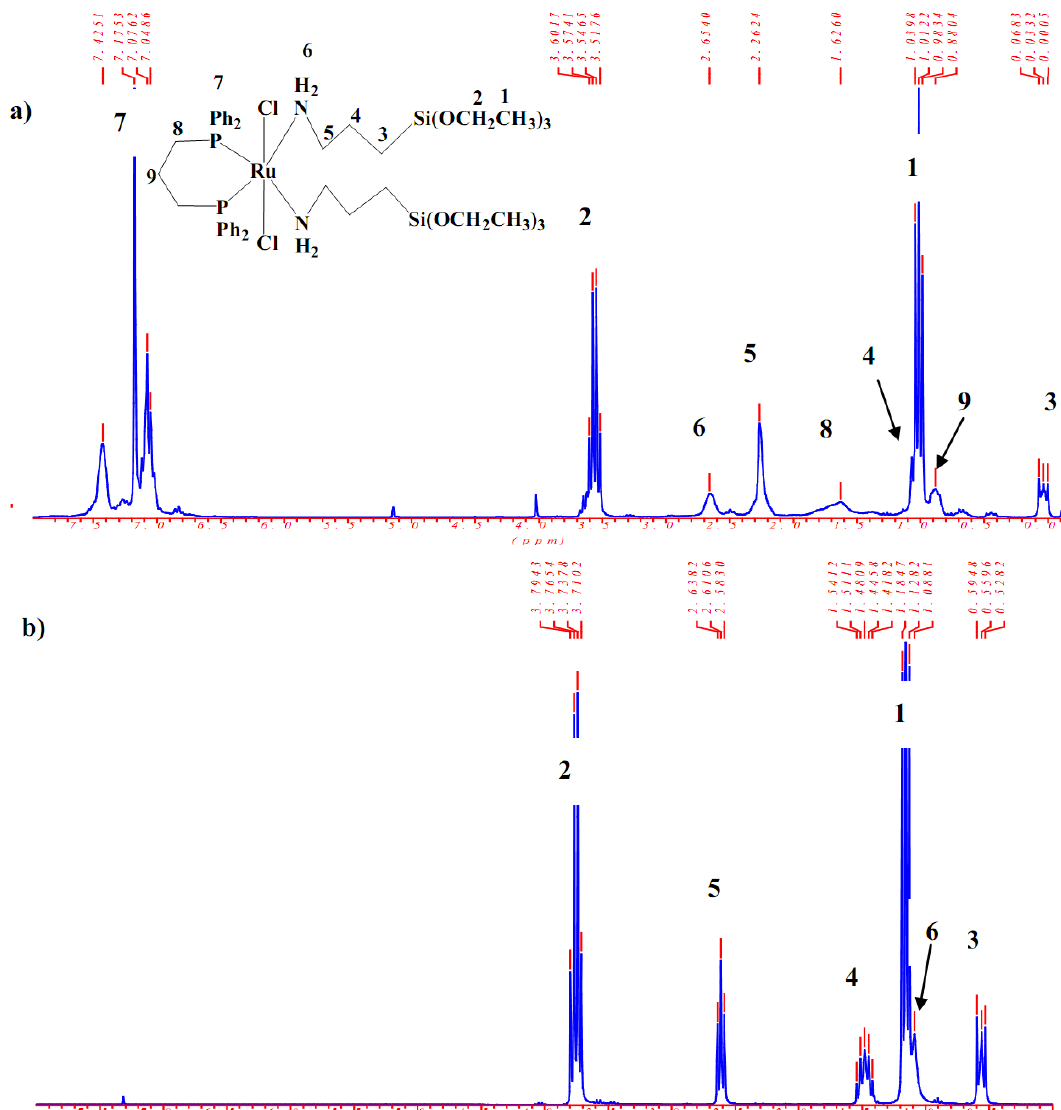
Figure 4. 1 H-NMR of complex 3: a) and free ligand 3-(triethoxysilyl)propylamine; b) in CDCl at room 3